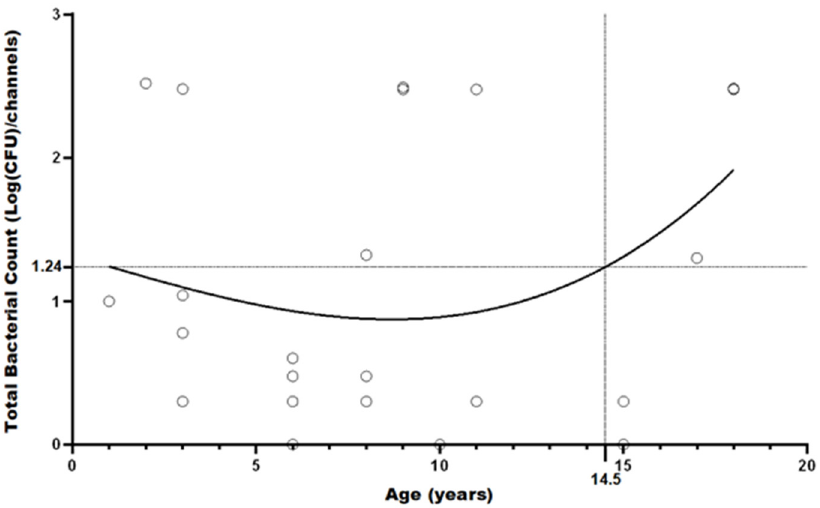
Figure 2. Relationship between the age of bronchoscopes and total bacterial count detected on bronchoscopes.